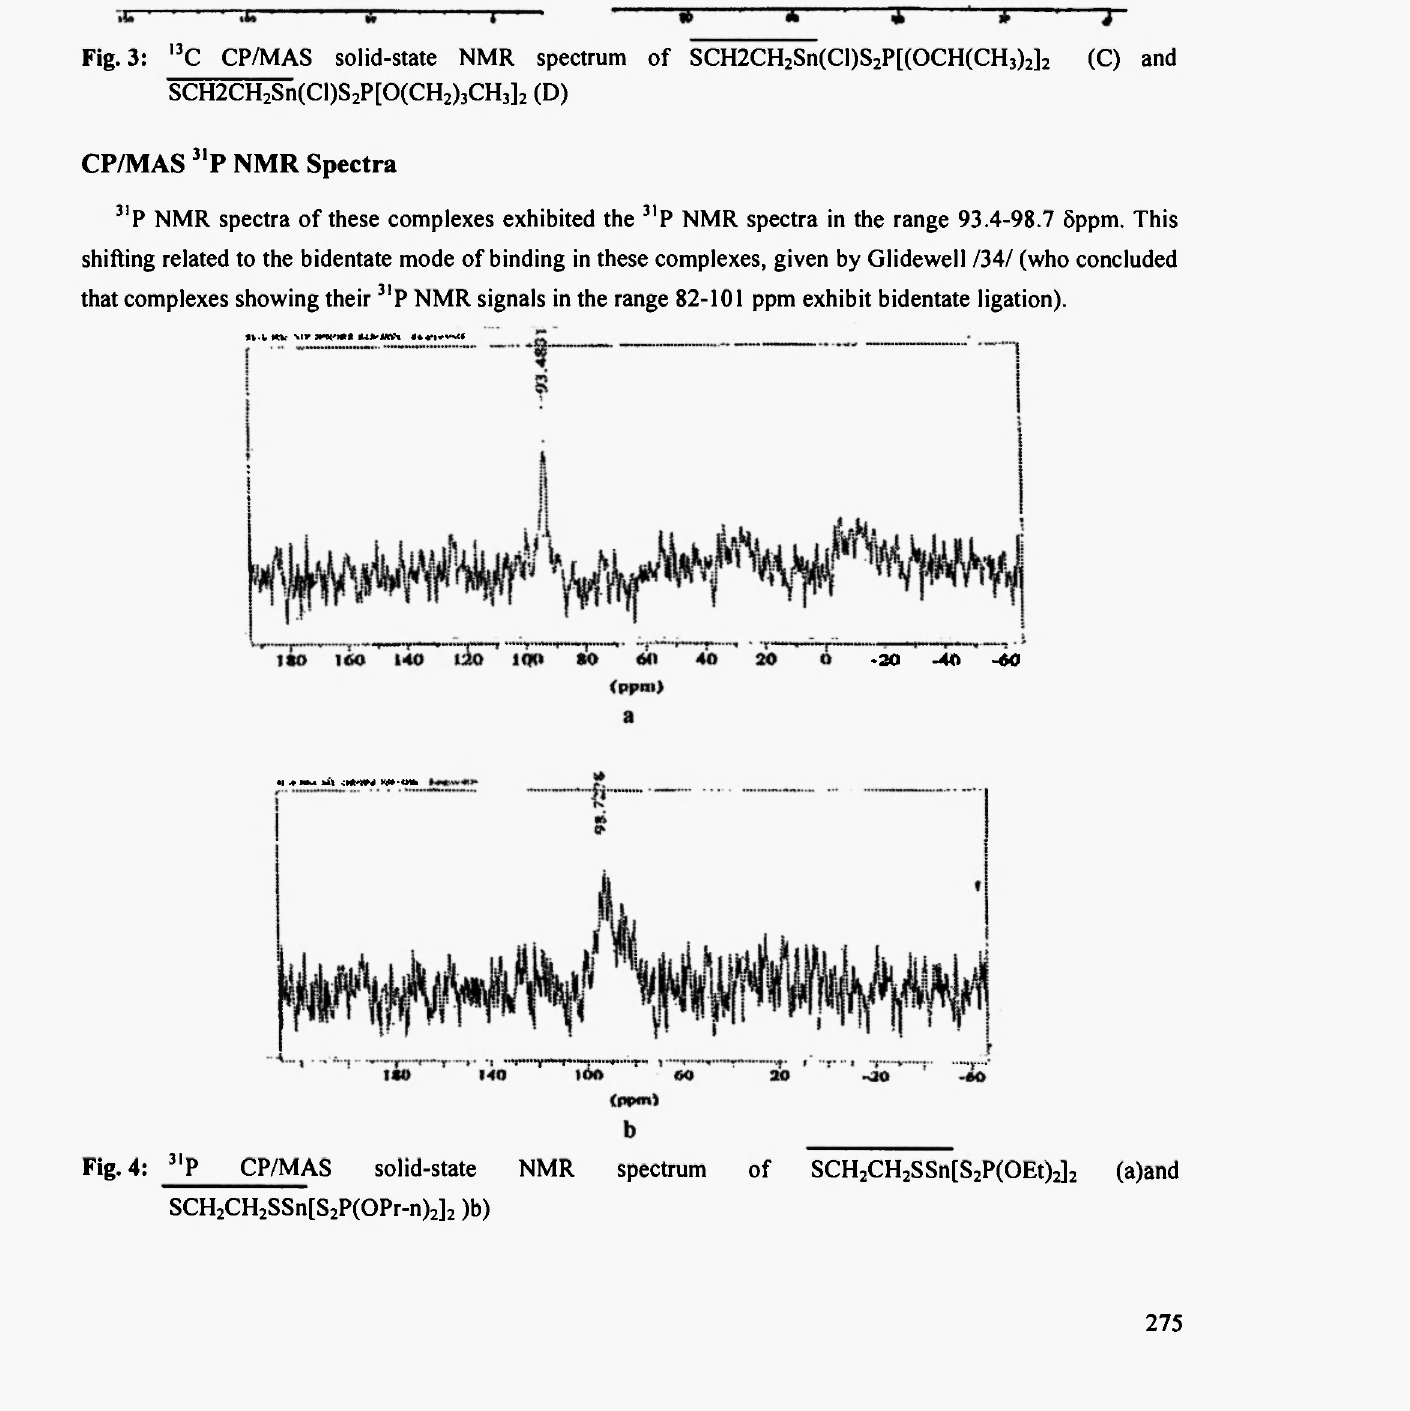
Fig. 3: ,3 C CP/MAS solid-state NMR spectrum of SCH2CH